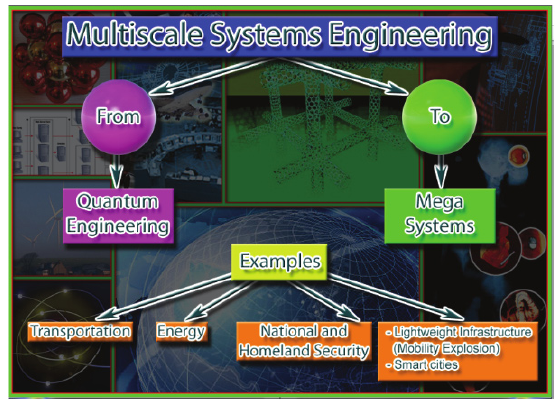
Figure 2. Examples of applications of multiscale systems engine-